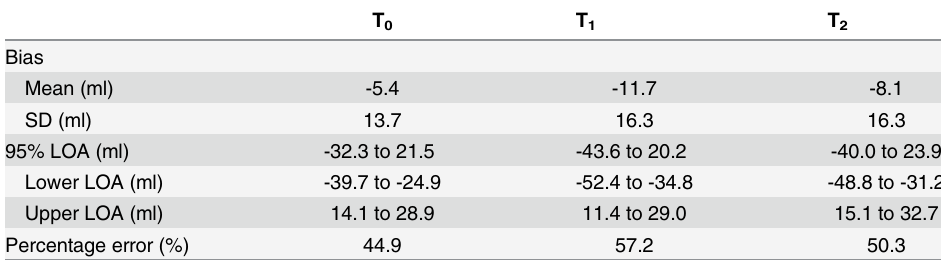
T 0 , after anesthetic induction in supine position; T 1 , 3 minutes after the steep Trendelenburg position (35°) was added to pneumoperitoneum during which time insuf fl ation pressure was set to 15 mmHg; T 2 , 3 minutes after 500 ml of colloid infusion in T 1 ; SV-Vigileo, stroke volume derived by the FloTrac/Vigileo ™ system; SV-TEE, stroke volume measured using transesophageal echocardiography; LOA, limit of